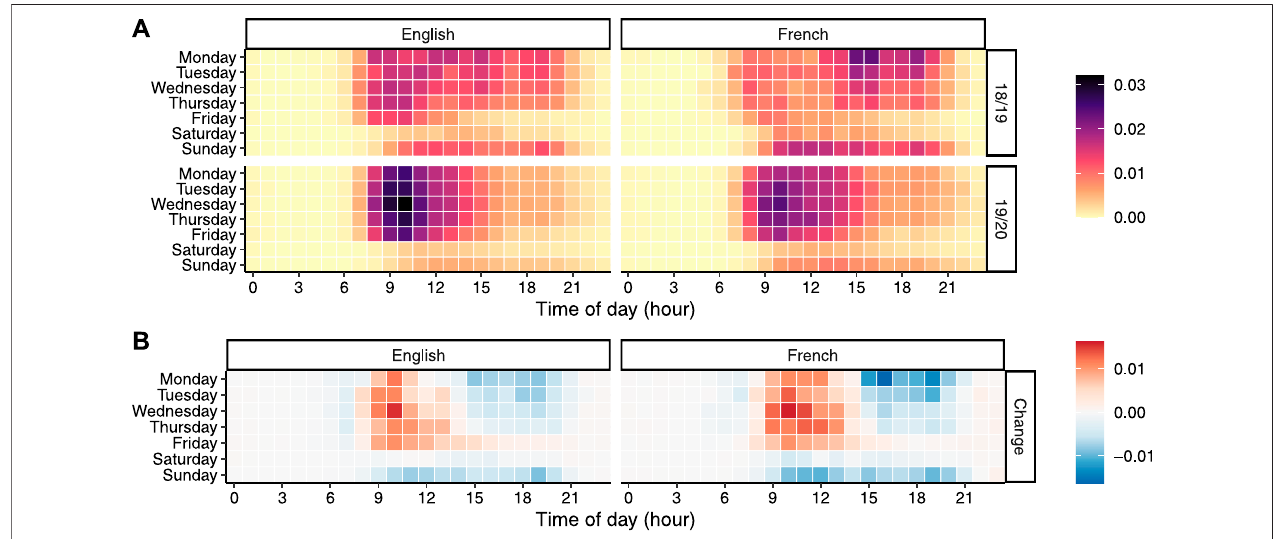
FIGURE2|(A) Distributionofstudytrialsovertheweekduringtheschoolclosureperiod(16March – 2June)inbothschoolyears.Thecolourofeachsquareshows howmanytrialswererecordedinalearningsessionstartingwithinaparticularhouronaparticularweekday,asaproportionoftheentireweek. (B) Changeindistribution of study trials from the 18/19 school year to the 19/20 school